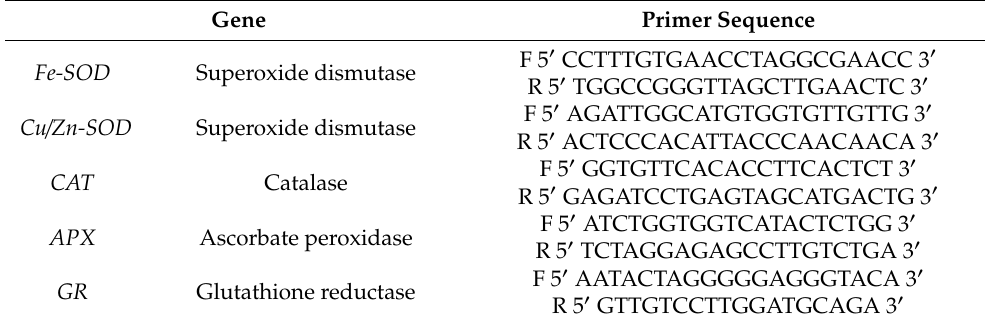
Table 1. Primer sequences for the genes of the reactive oxygen species pathway analyzed in this